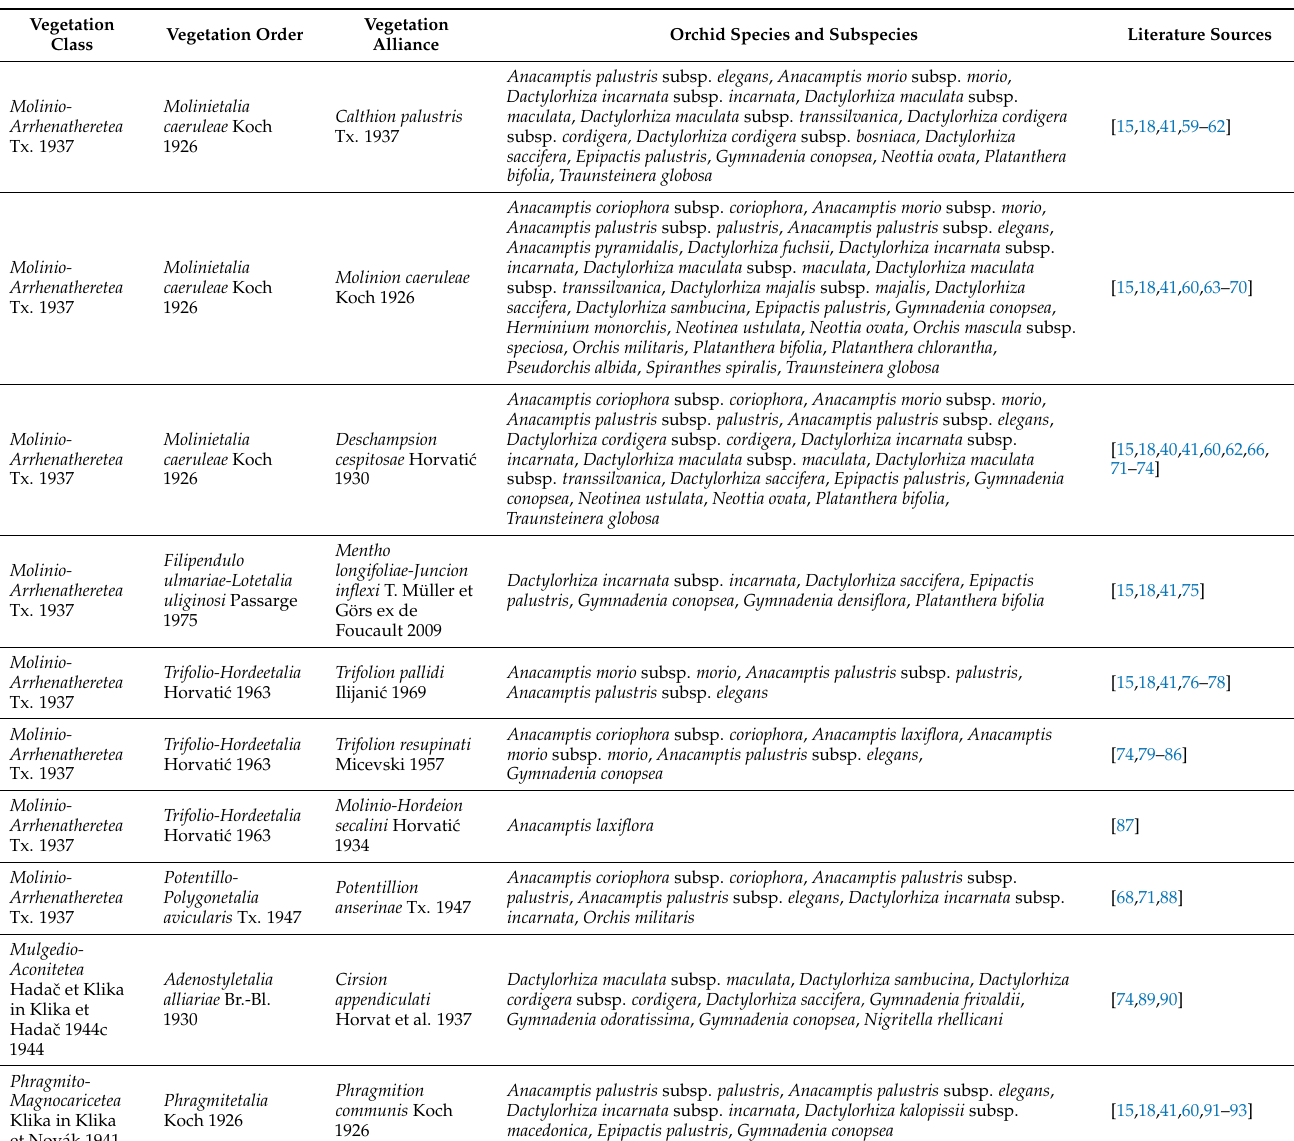
Table 2. Overview of wetland vegetation types with terrestrial orchids in the Central